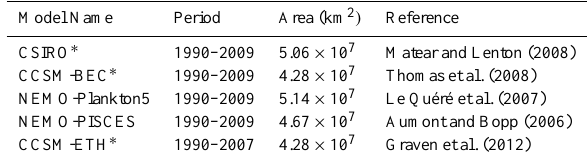
Table 1. The list of ocean biogeochemical models, the periods over which the data were evaluated and the reference to each model, and the surface area between 30 ◦ N and 44 ◦